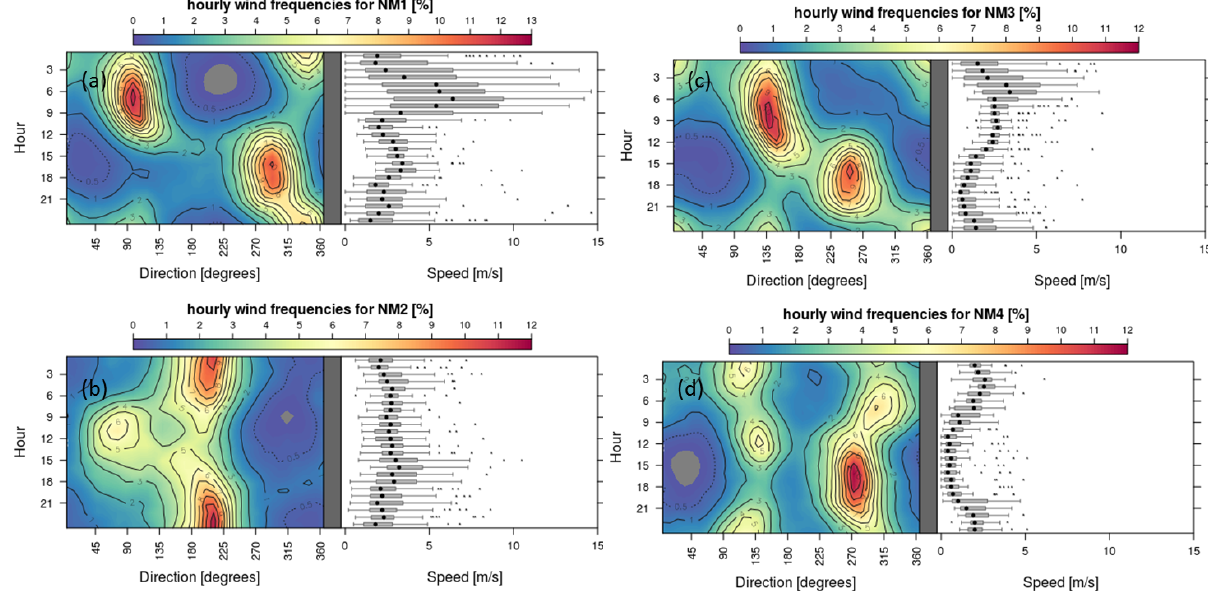
Figure 15. Contour plots of hourly wind frequencies and corresponding wind speeds for the NM transect at the Salmon River Canyon site. NM1 (a) is near the ridge top. NM4 (d) is near the canyon bottom. All data were used.